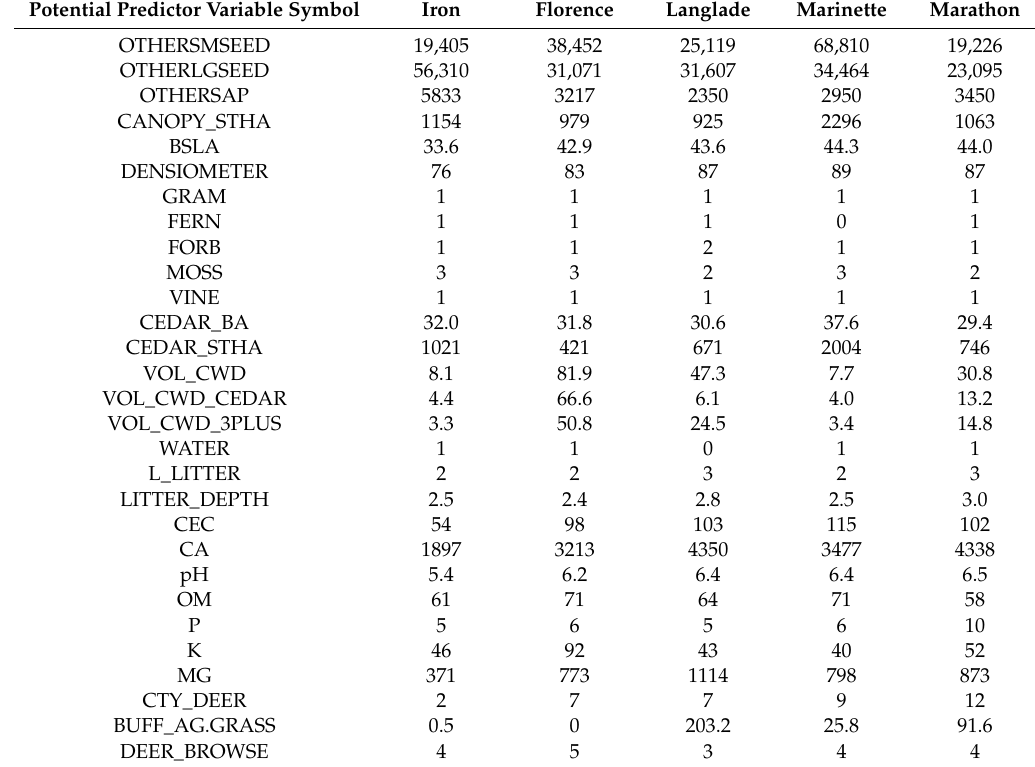
Table A1. Site-level means for all potential predictor variables measured. See Table 2 for definitions of variable